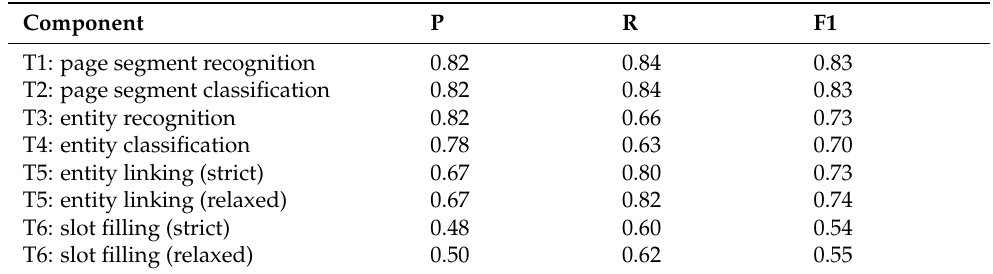
Table 6. Slot filling and per component evaluation